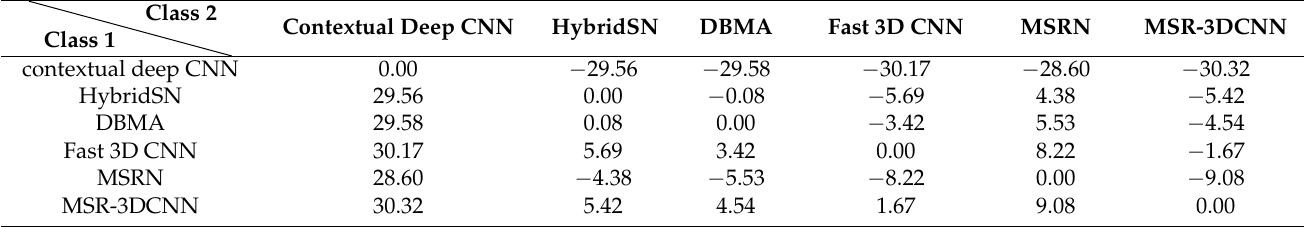
Table 8. Standardized normal test statistic (Z) for the IP dataset using ( 9 × 9 ) patch size and 10% samples for training.